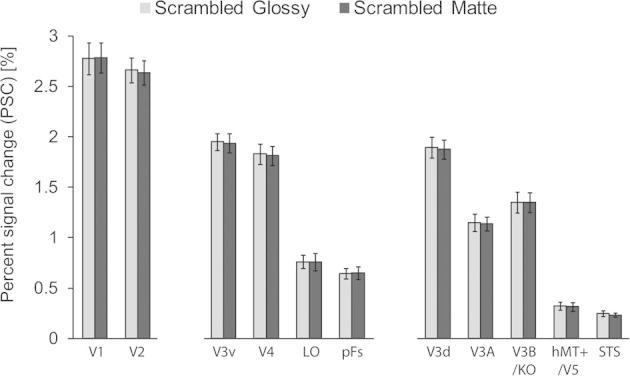
The PSC of Scrambled Glossy condition (light bar) and Scrambled Matte condition (dark bar). No significant difference was found between the two conditions in each ROI.